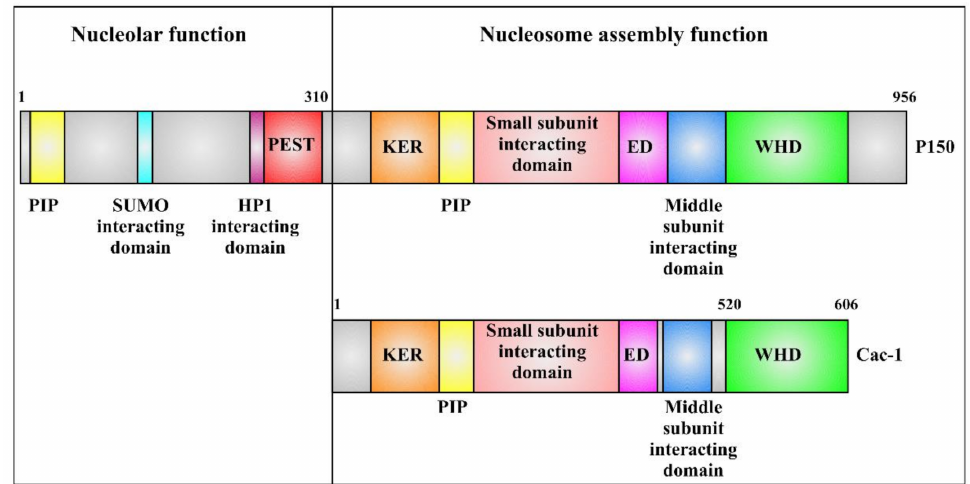
Figure 1. Schematic representation of P150 and Cac-1 components. The N-terminal region of P150 (residues 1–310) contains a PCNA interacting peptide (PIP) that has a strong activity in vitro, a SUMO protein interacting domain, an HP1 interacting region, and a PEST domain. The C-terminal region of P150 (residues 311–956) shows a domain organization similar to Cac-1. Both proteins contain a KER region, a PIP which is mainly responsible for maintaining the in vivo interaction with PCNA [40], the small subunit interacting domain, the ED sequence, the middle subunit interacting domain, and a WHD